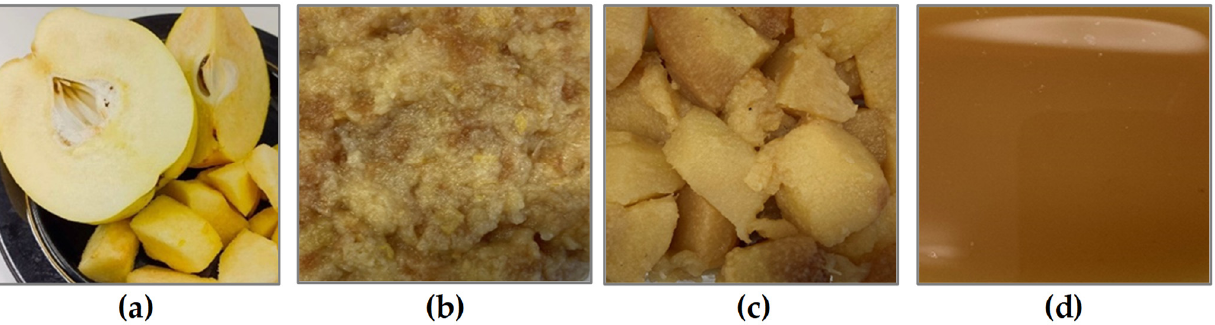
Figure 1. Changes in the appearance of fresh quince fruit ( a ) after technological processing: cooking in boiling water ( b ), frying in a pan without fat, ( c ) and juicing ( d